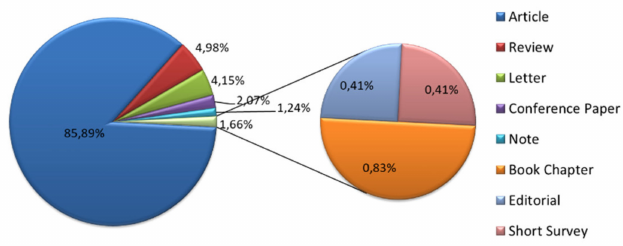
Figure 1. Literature contribution of di ff erent types of